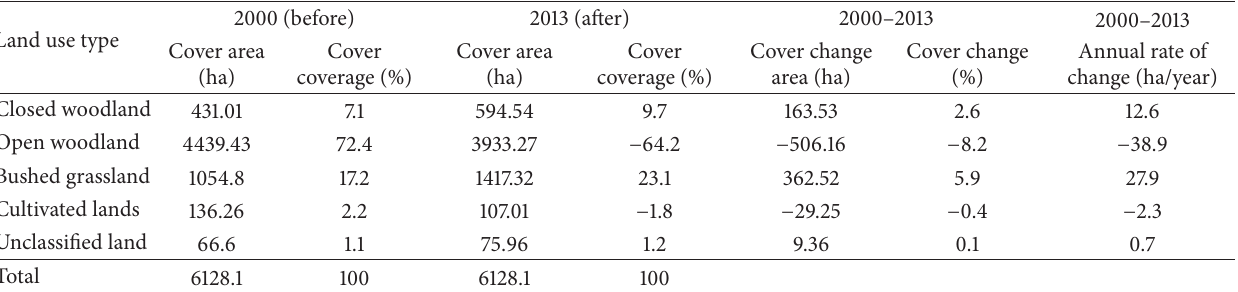
Table 4: Land use and miombo cover change before and after CBFM, Gangalamtumba.